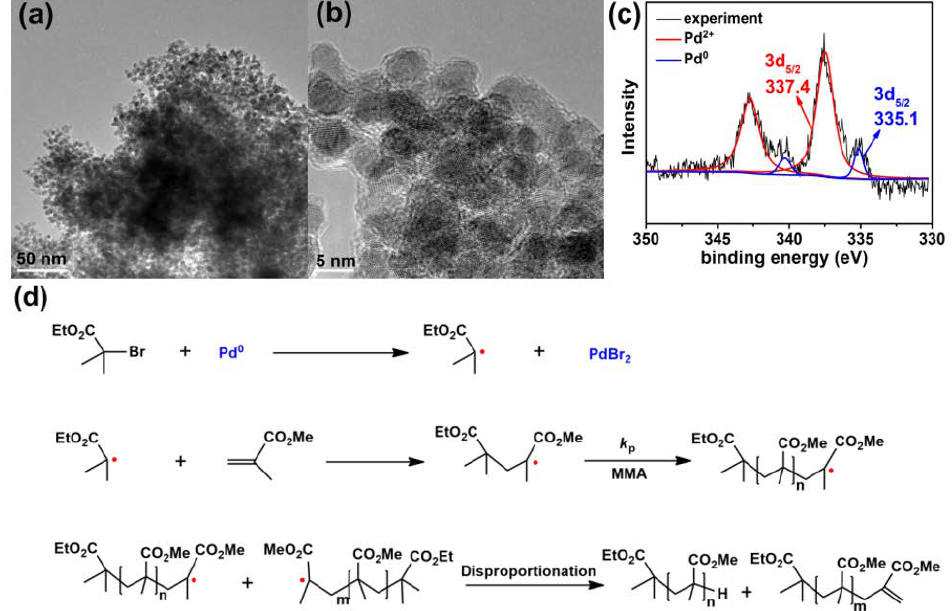
Figure 5. TEM images ( a , b ), XPS spectrum ( c ) of Pd NPs collected during the polymerization of MMA and the corresponding postulated mechanism of the polymerization of MMA ( d